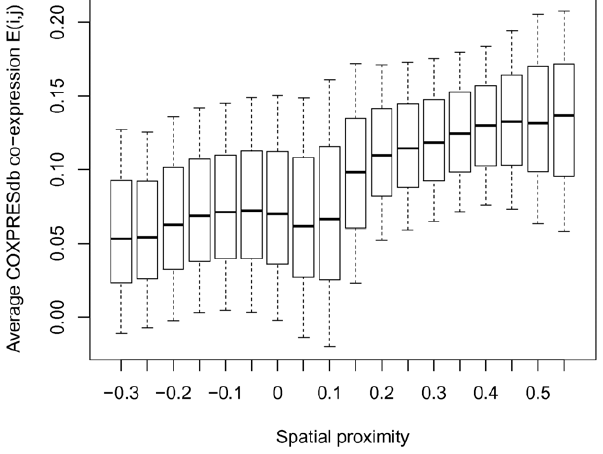
Figure 6. Correlations of the spatial proximity values with the expression level difference in the initial dataset and in the shuffled dataset.